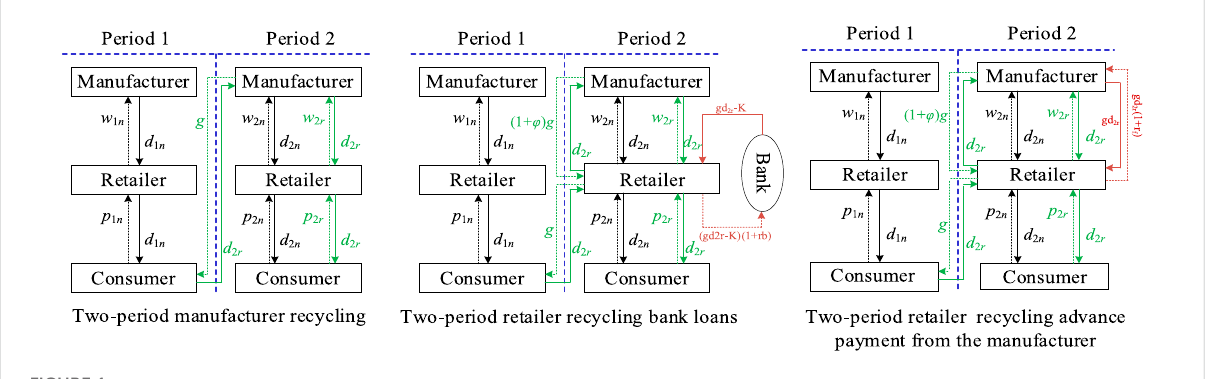
FIGURE 1 Structure diagram of the two-period